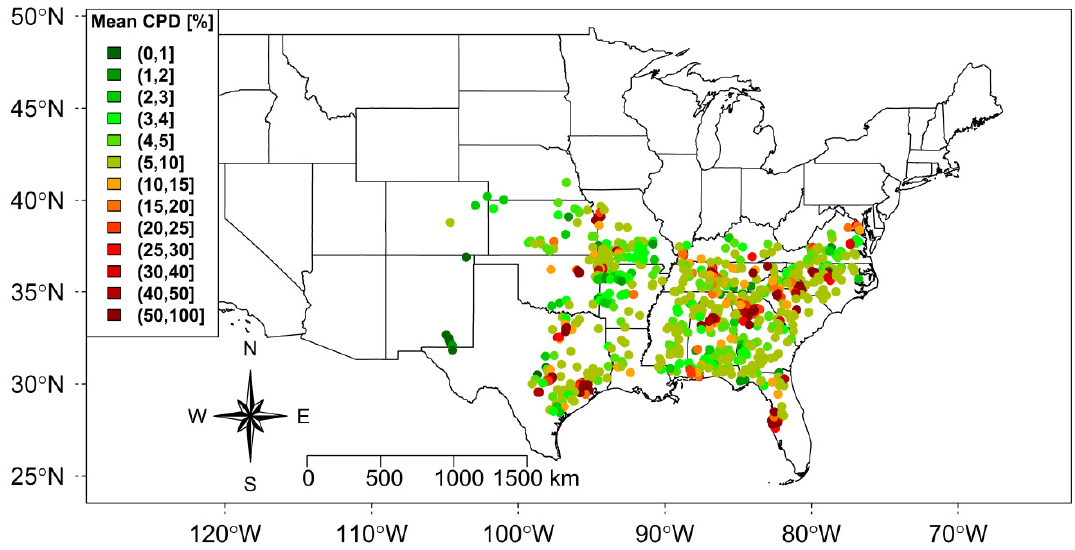
Figure 1. The location and mean Catchment Percent Developed (CPD) of the 870 U.S. catchments.